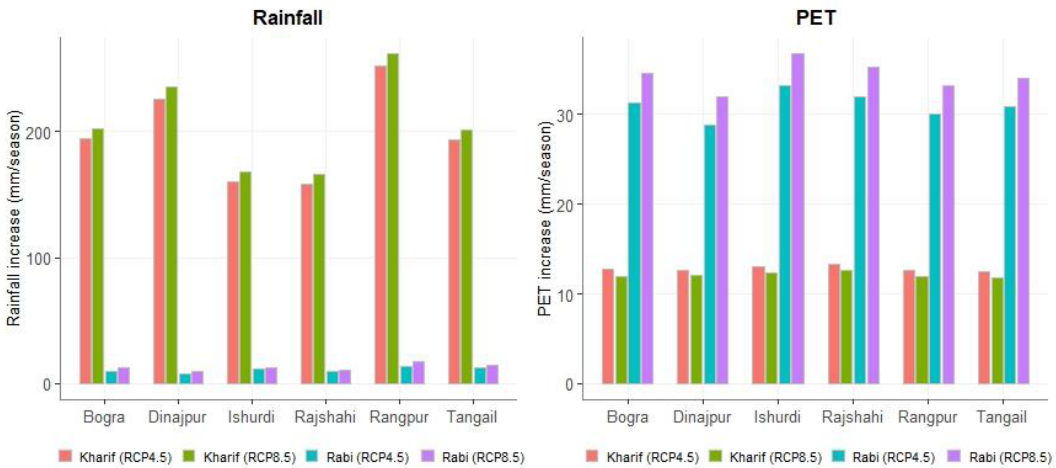
Figure 12. Projected changes in rainfall (left panel) and PET (right panel) during the Kharif and Rabi seasons in the northwest region of Bangladesh. seasons in the northwest region of